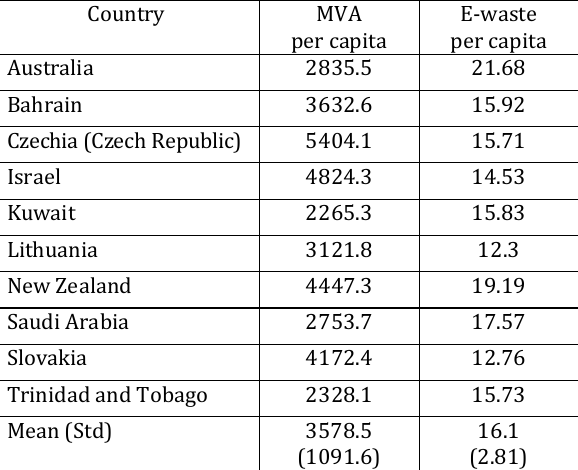
Table 9. Descriptive data (high-income countries) Country MVA E-waste per capita per capita